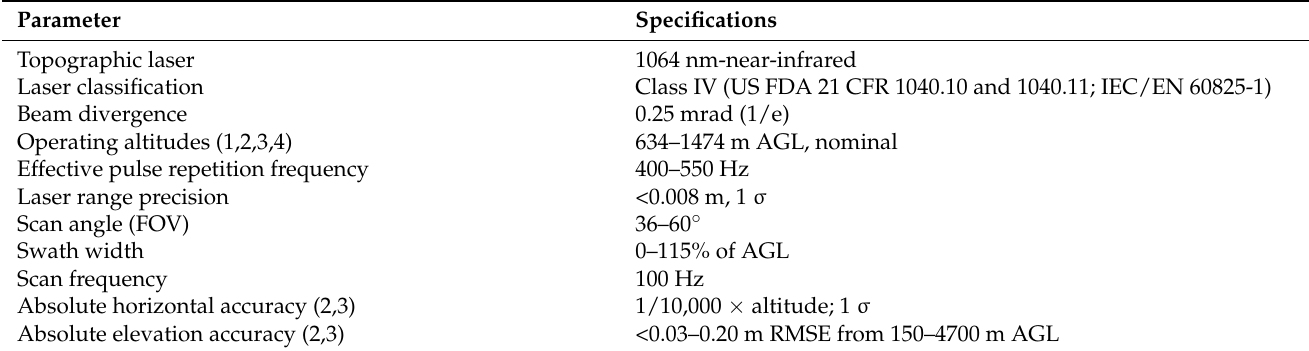
Table 1. Configuration of the Teledyne Optech (Teledyne Optech, Toronto, Canada) laser for the data collection on 23/07/19. FOV stands for